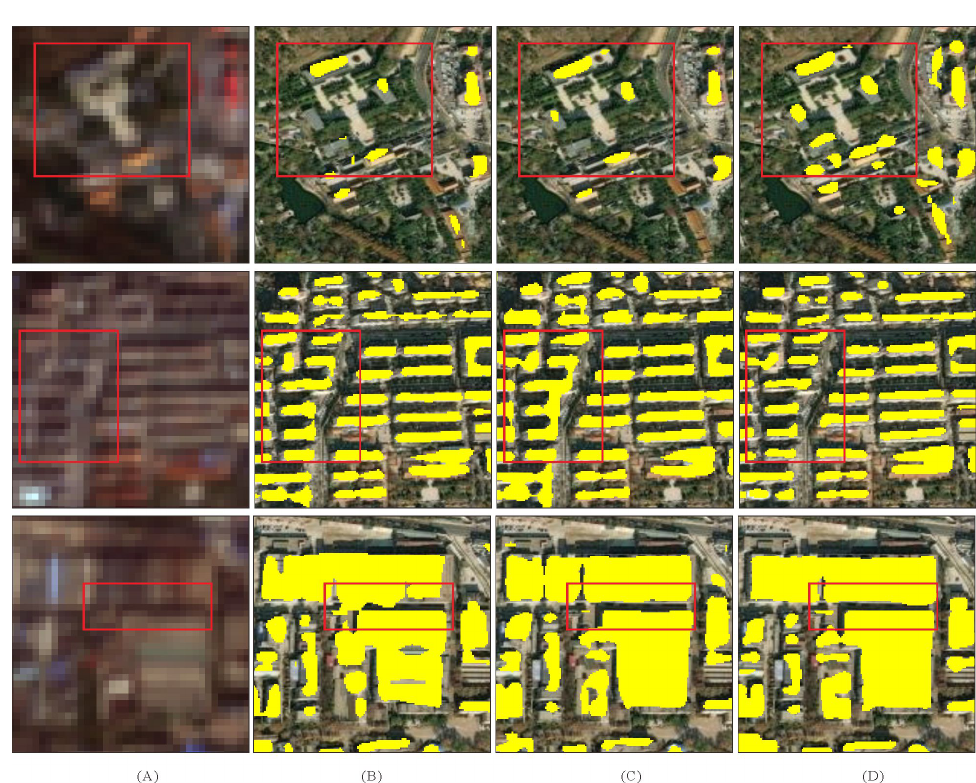
Figure 13. Examples of the super resolution and then semantic segmentation results obtained by the different methods in Sentinel-2 images. ( A ) The image tile (10 m/pixel). ( B – D ) The building extraction results (2.5 m/pixel) from ESPC_NASUnet, FSRSS-Net, and our SGFANet under the SR-then-SS framework, respectively. For better visual effects, we used the 2.5 m image from Esri community as the base map. The red squares indicate our notable